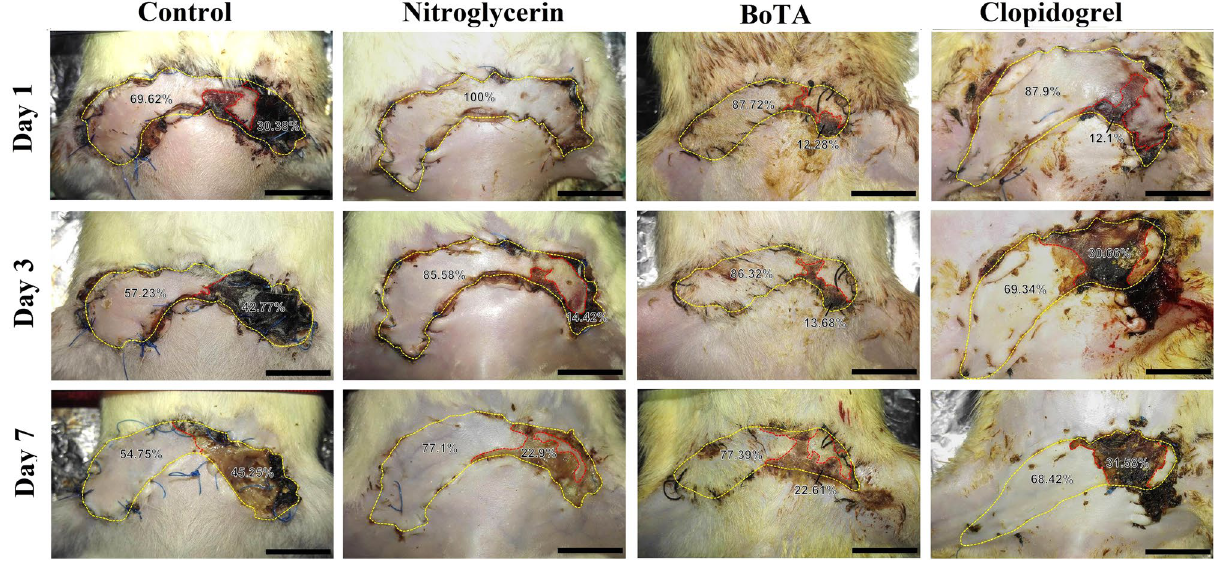
Figure 3. Gross appearance of skin flaps of the induced venous congestion subgroups at days 1, 3, and 7 after the operation. The yellow dotted line outlines the total flap area and the demarcation between normal and necrotic tissues is indicated by the red dotted line. (Scale bar = 1.5 cm).